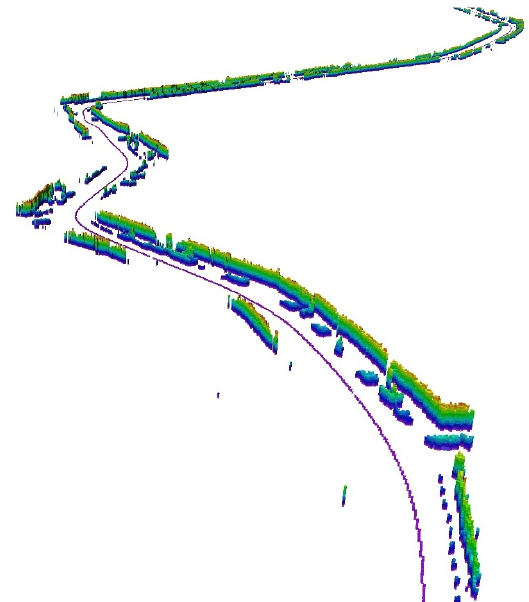
Figure 1: The result of the mapping approach for a 3 . 000 image sequence. For the visualization and the data structure the Oc- toMap Representation (Wurm et al., 2010) is used. The purple line represents the driven path of the ego vehicle. The height of the static environment is color